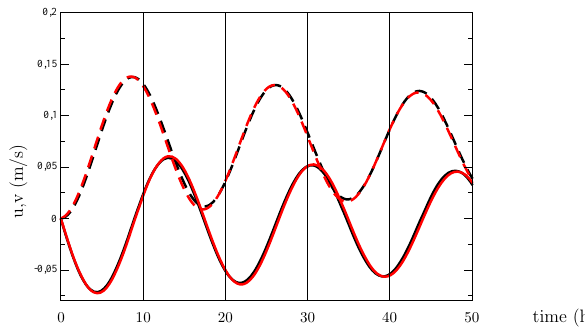
Fig. 8. Time evolution of the averaged u-component (full black line) and v-component (dashed black line) and the corresponding best fits (red) using Eqs. (30) and (31) and the parameter values given in Table